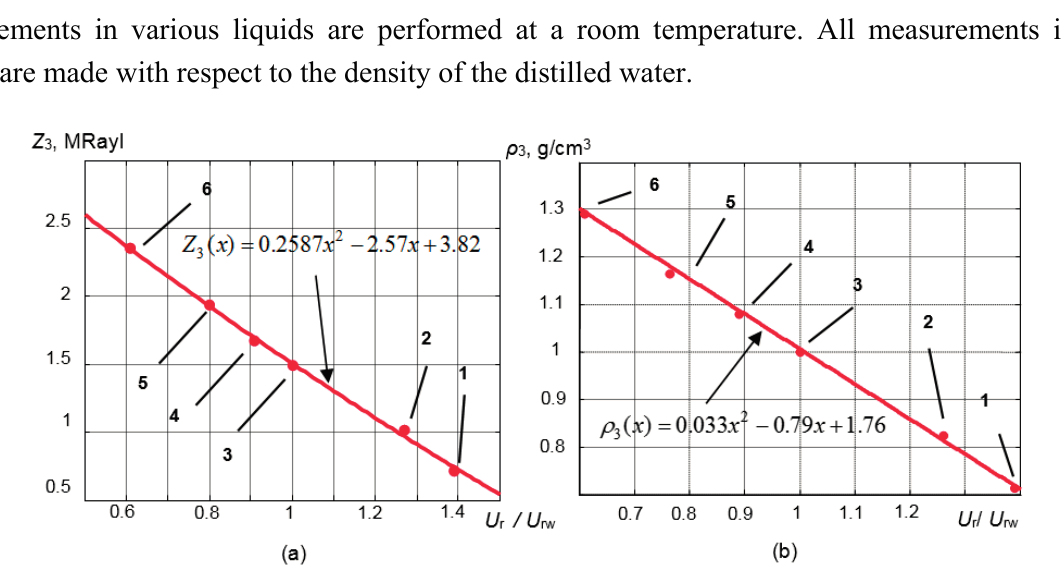
Figure 14. ( a ) Relationship between the normalized amplitude U r / U r w and the acoustic impedance of the measured liquid; ( b ) relationship between the normalized amplitude U r / U rw and the density of the measured liquid. (1, ethyl ether; 2, ethyl alcohol; 3, distilled water; 4, 20% sugar/water; 5, 40% sugar/water; 6, 60%